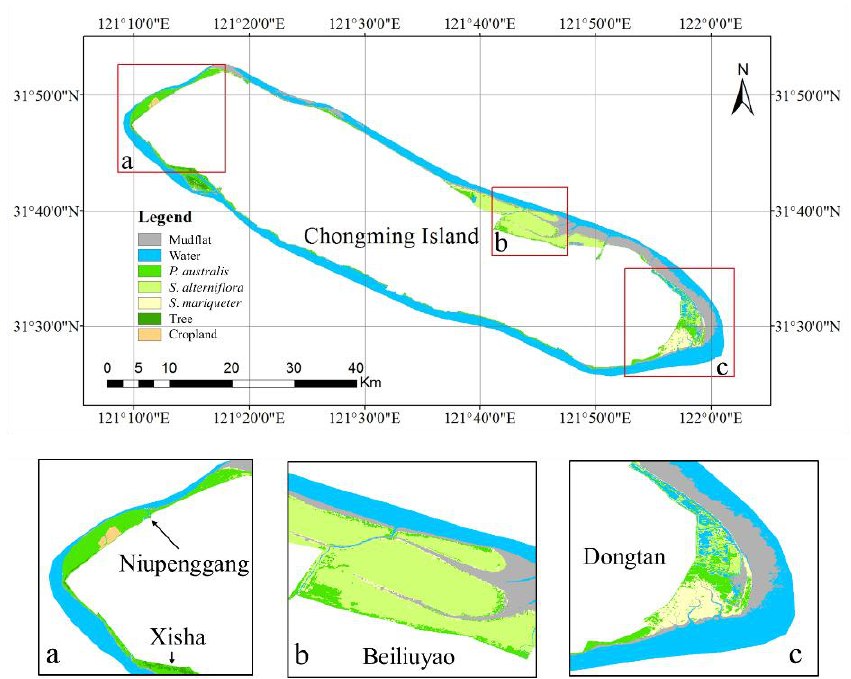
Figure 7. Classification considering statistical, temporal, and phenological features. Subfigure ( a ) shows the Xisha and Niupenggang areas, subfigure ( b ) shows the Beiliuyao area, and subfigure ( c ) shows the Dongtan area.